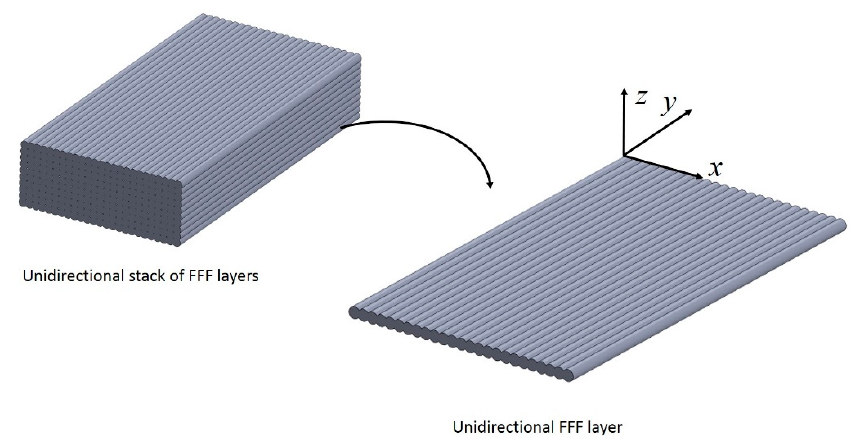
Figure 6. Schematic representation of a unidirectional stack of FFF layers.